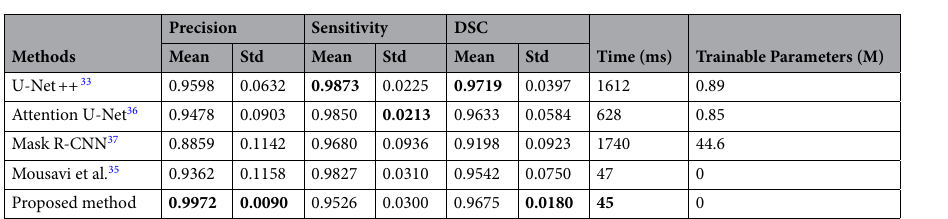
Table 3. The result of different nucleus segmentation algorithms evaluated on 250 test images; DSC (dice similarity coefficient), Std (standard deviation), ms (millisecond), M (million). Bold values Illustrate the best- obtained